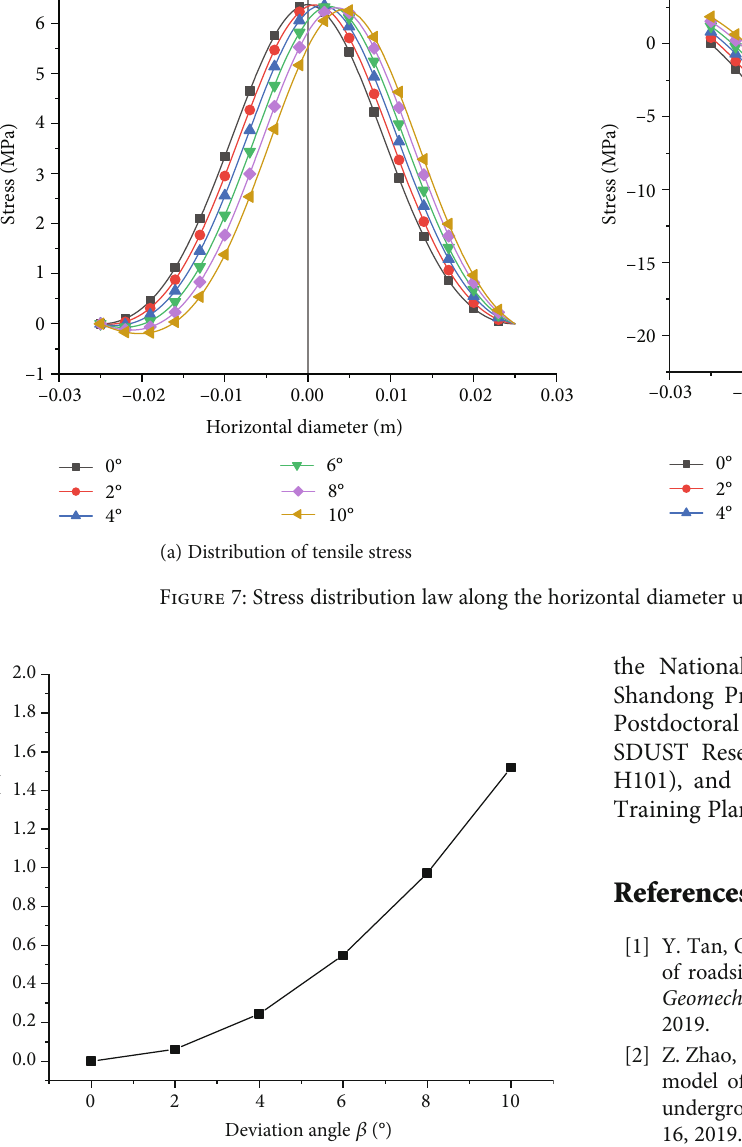
Figure 8: The evolution law of error impact rate with deviation